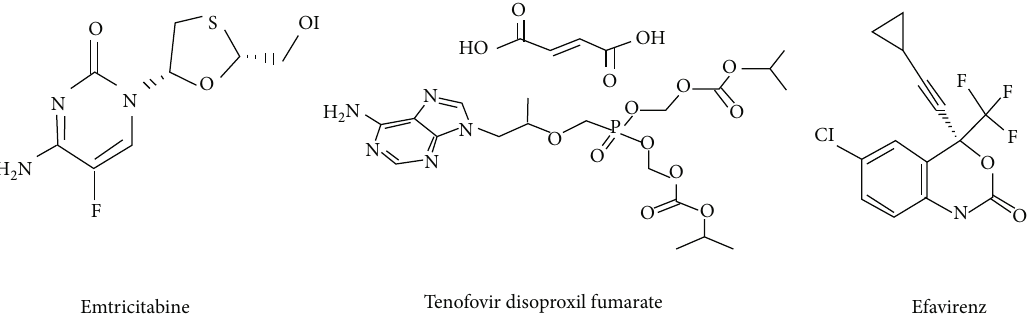
Figure 10: Structure of emtricitabine, efavirenz, and tenofovir disoproxil fumarate showing various functional groups present in each drug component of HAART. Adapted from